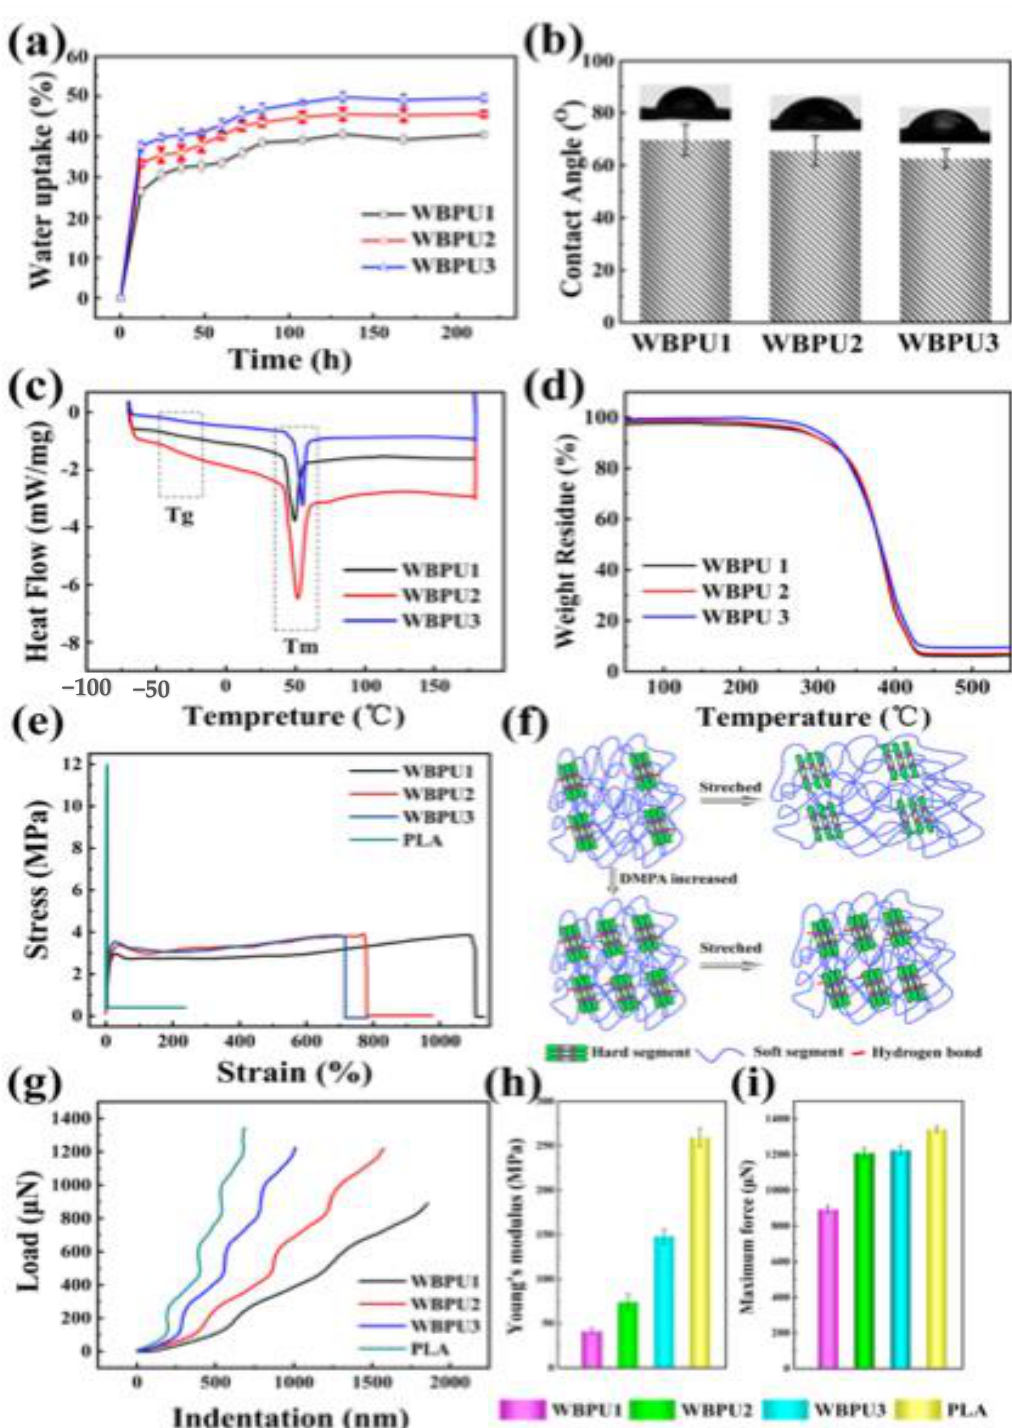
Figure 9. ( a ) The water uptake. ( b ) Water contact angle. ( c ) Thermal stability (TGA) and ( d ) DSC thermograms of WBPU films with different dimethylol propionic acid (DMPA) content. ( e ) The stress–strain curves of WBPU and PLA films. ( f ) The schematic diagram of the molecular chain structure during tensile mechanics. ( g ) The load-indentation curves of WBPU and PLA films. ( h ) The Young’s modulus of WBPU and PLA films. ( i ) The maximum force of WBPU and PLA films (reproduced with permission from [86]).